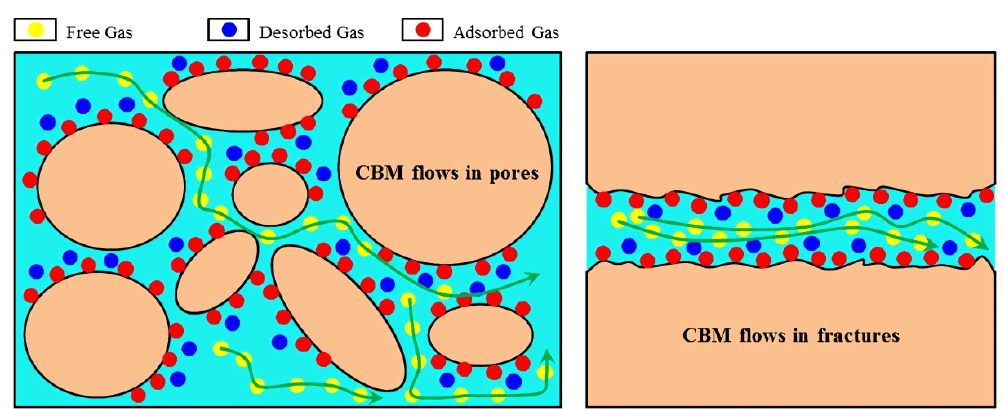
Figure 2. Occurrence and migration state of CBM in the reservoir.